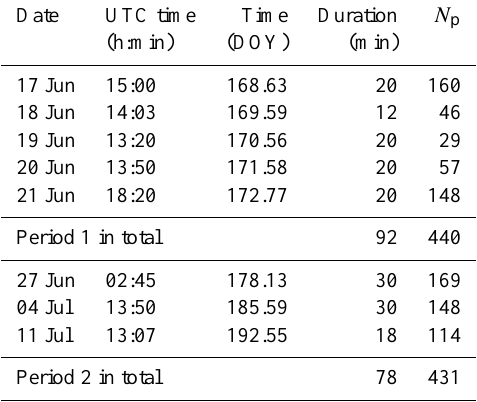
Table 2. Information about the samples investigated with transmis- sion electron microscopy. Date and UTC time represent the begin- ning of the sampling, while time in DOY is the midpoint of the sampling time. Duration gives the sampling time in minutes. N p is the number of particles